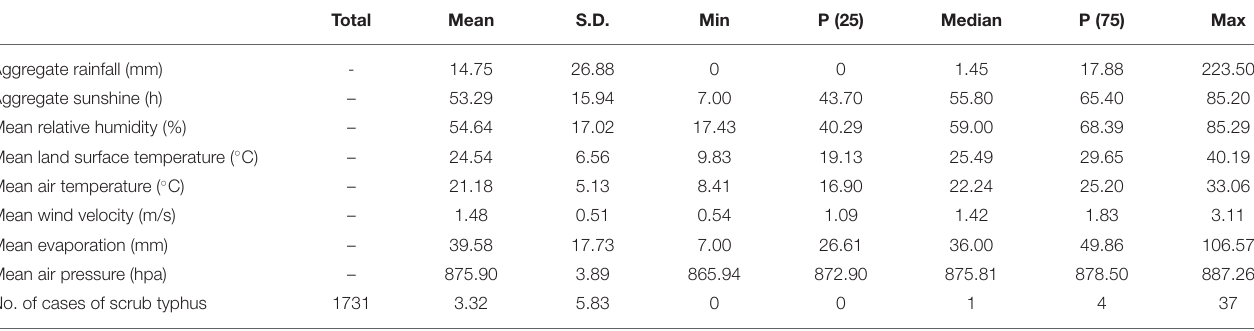
TABLE 1 | Summary statistics for weekly scrub typhus cases and meteorological variables in rural areas of Panzhihua district, Southwest China, 2008–2017.